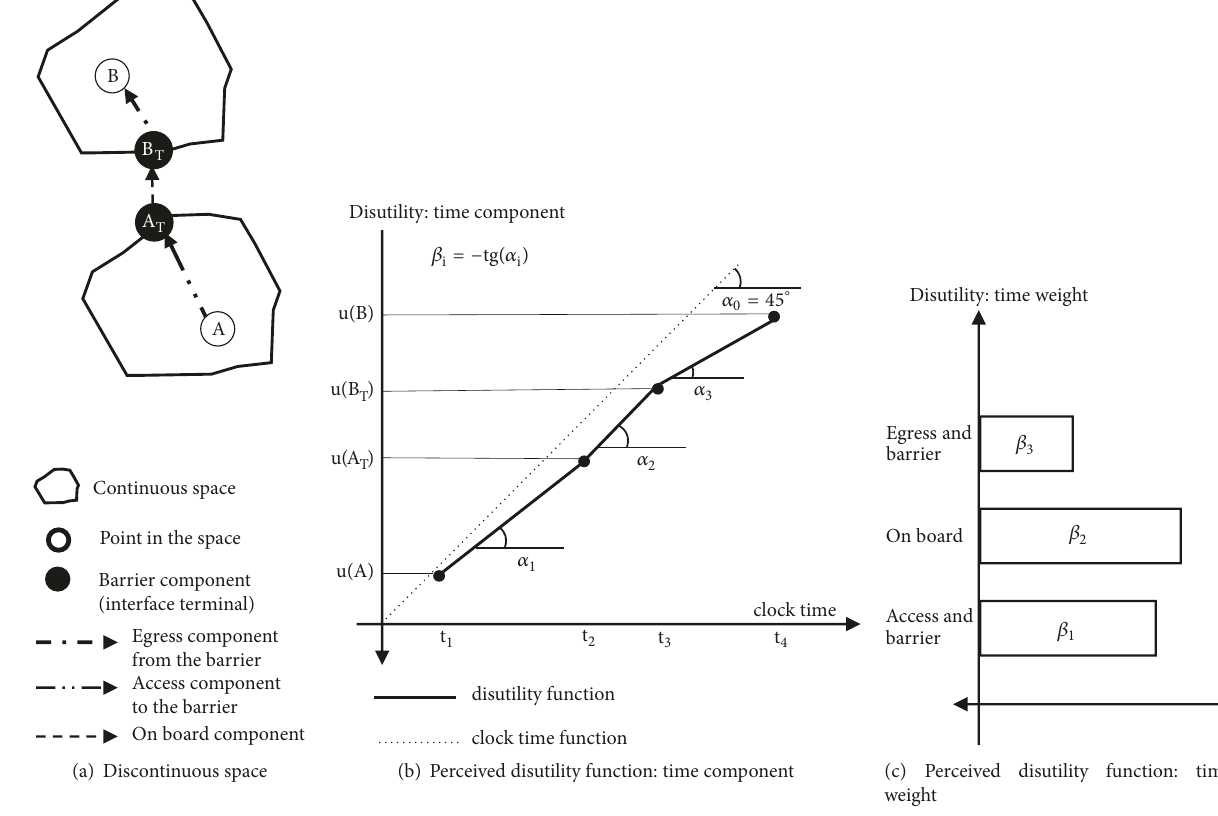
Figure 1: Travel in discontinuous space: Disutility